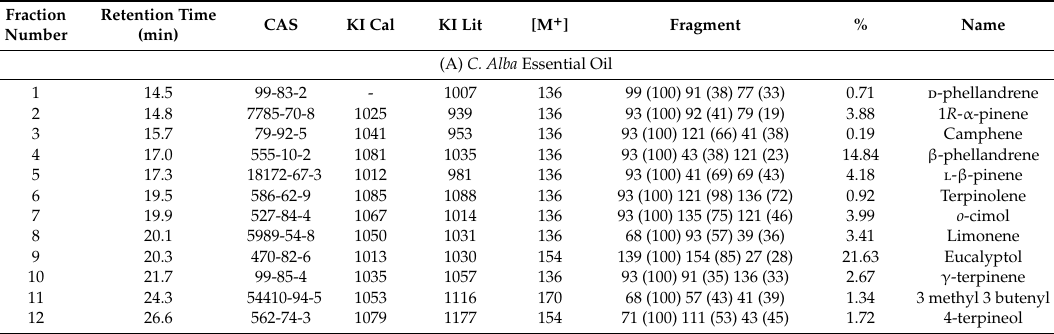
Table 1. Compounds from GC-MS analyses of (A) C. alba and (B) L. sempervirens EOs, the respective calculated Kovats index (KI cal) and from the Kovats index literature (KI